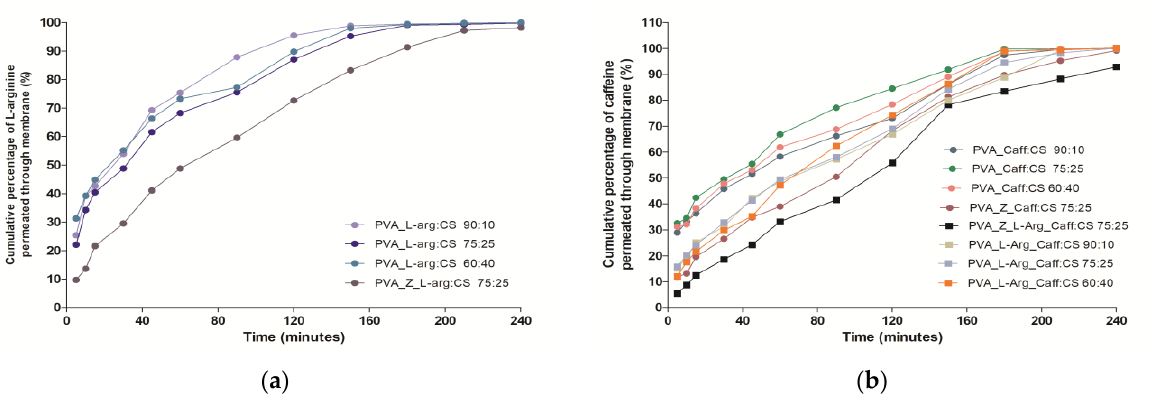
Figure 4. In vitro release profile: ( a ) L-arg and ( b ) Caff from the hydrogel samples.